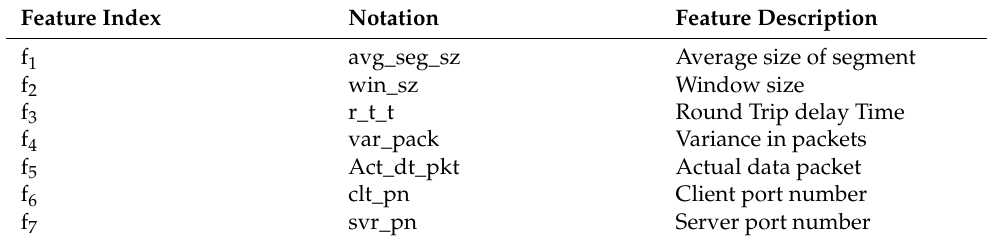
Table 3. Network data features and its notation.